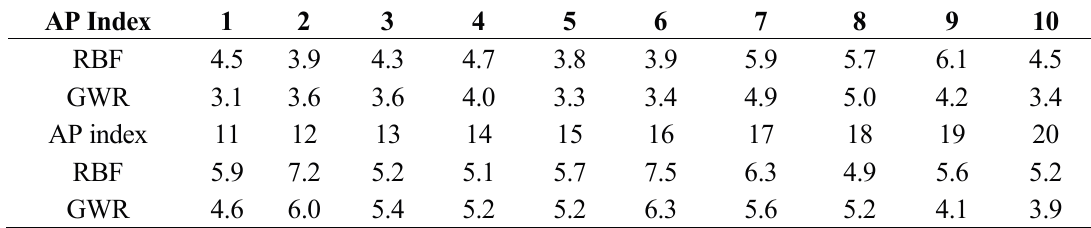
Table 5. Comparison of average RSSI Errors (dBm) between RBF and GWR in scenario two.